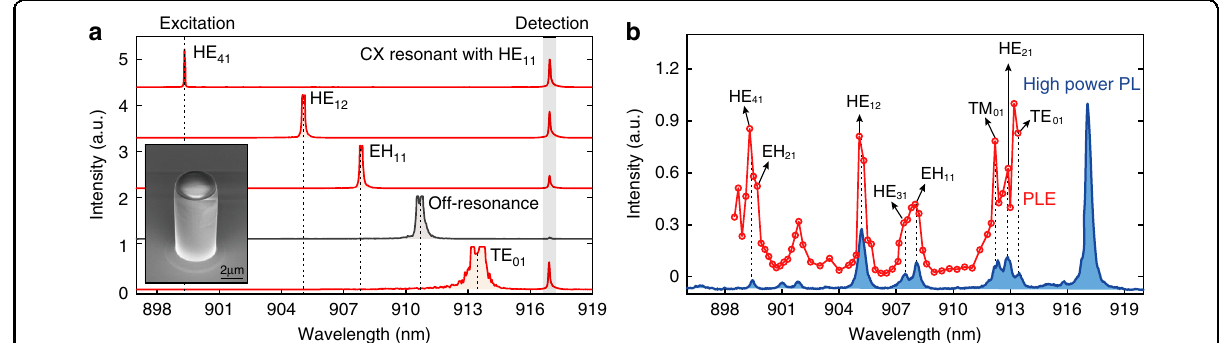
Fig. 2 Identi fi cation of the cavity modes of the micropillar. a PL spectra for the QD-micropillar excited by a laser with varied wavelengths. The CX emission is resonant and therefore enhanced by the HE 11 mode. Appreciable CX emission is observed when the excitation laser is resonant with one of the high-order cavity modes (red spectrum). In the off-resonance condition, the CX emission intensity is negligible (black spectrum). Inset, SEM image of the fabricated micropillar. b PLE spectrum (red) for the CX state resonant with the HE 11 mode and the PL spectrum (blue) of the QD-cavity system under high-power above-band excitation conditions. The high-power PL is shifted slightly in y direction for clarity